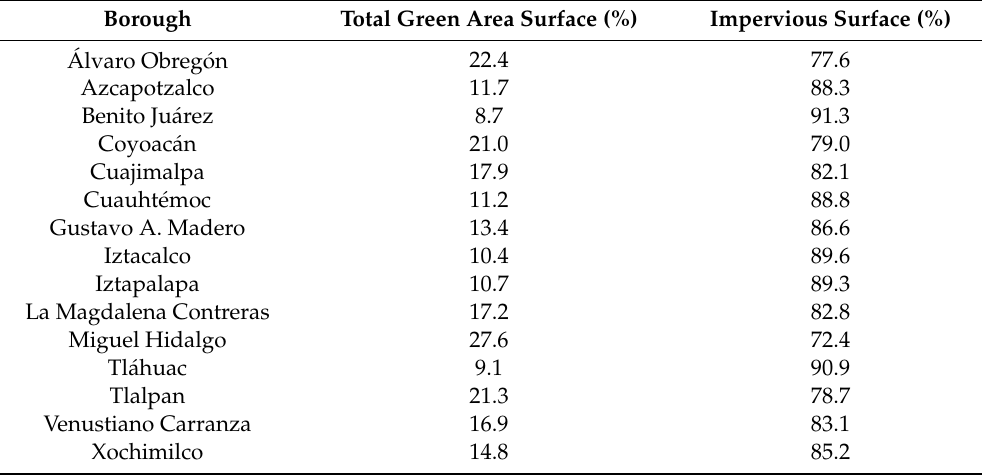
Table 5. Green area surface vs. impervious surface (grey surface) in Mexico City’s boroughs.